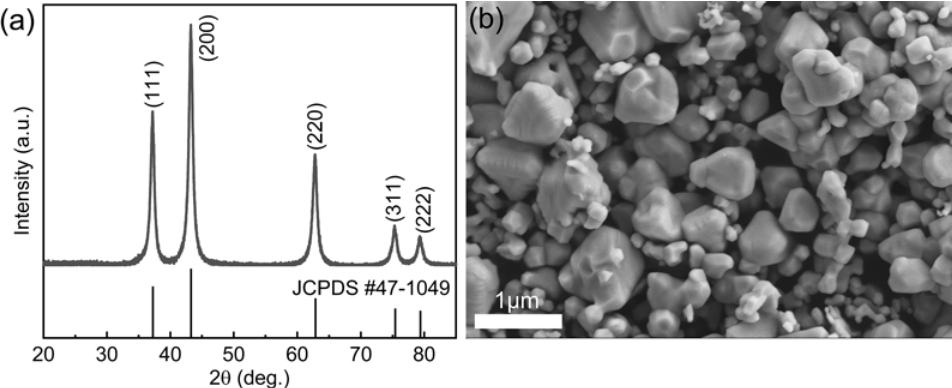
Figure 2. ( a ) XRD pattern of the commercial NiO powder employed in this study; ( b ) SEM image of the commercial NiO powder, with NiO particles ranging roughly from 100 nm to 1 µm. Teflon magnetic stirring rods were not designed for applications in tribo-catalysis.